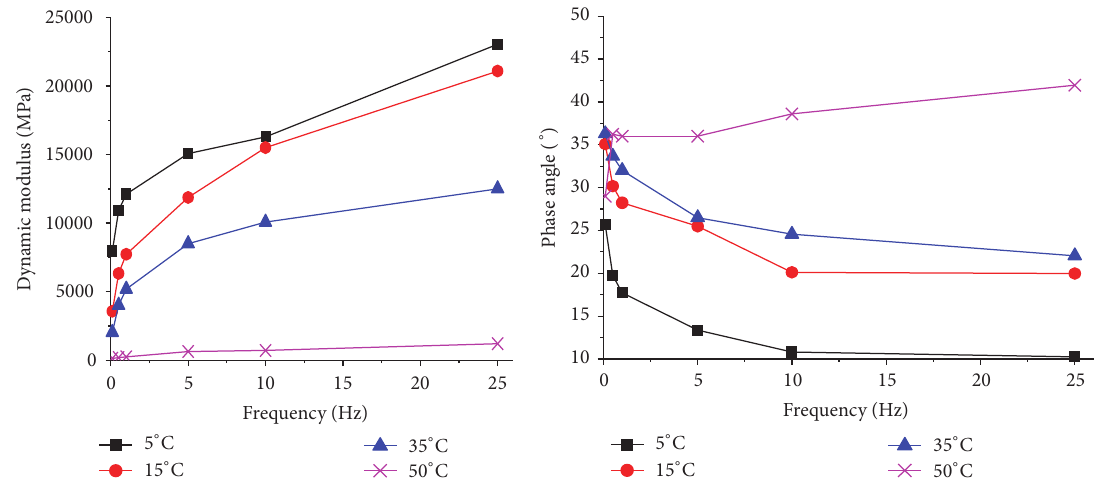
Figure 4: The dynamic modulus and phase angle of SBS modified asphalt.